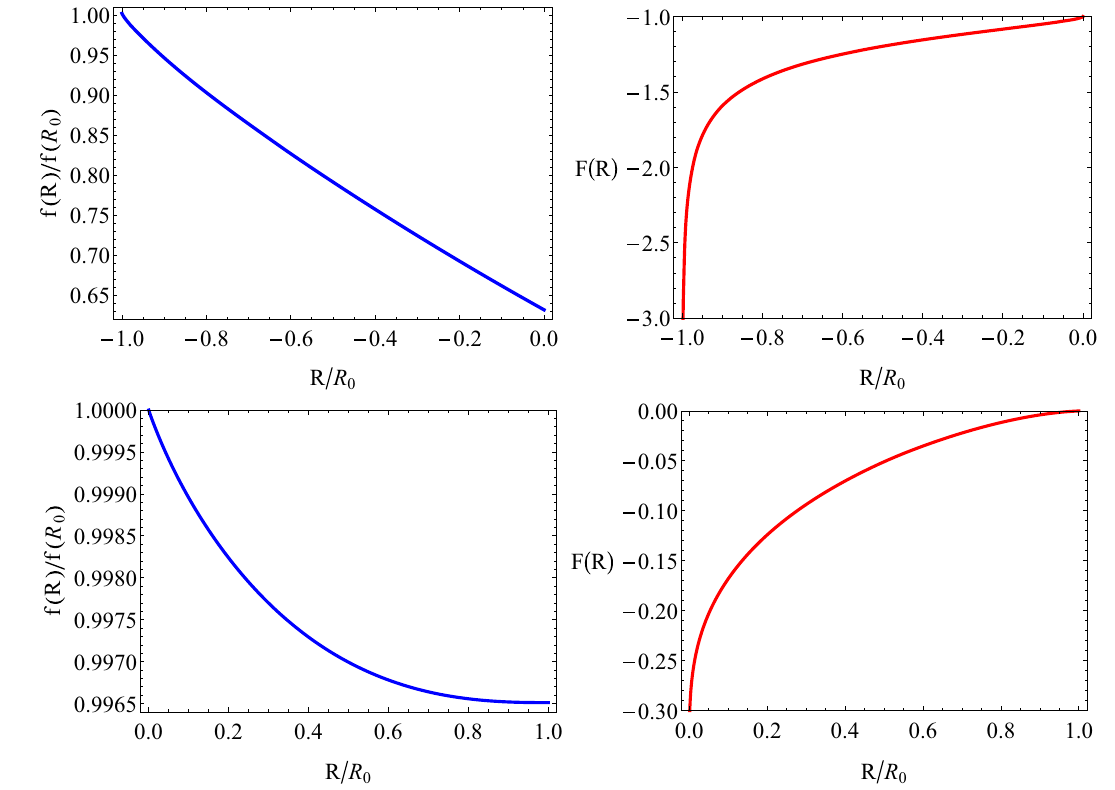
Fig. 5 Upper row: the trend of the dimensionless f ( R ) function (left panel) and its first derivative F ( R ) (right panel) against the dimensionless quantity R / R 0 for m = 1. Lower row: the behavior of the quantities f ( R )/ f ( R 0 ) and F ( R ) versus R / R 0 for m = 0